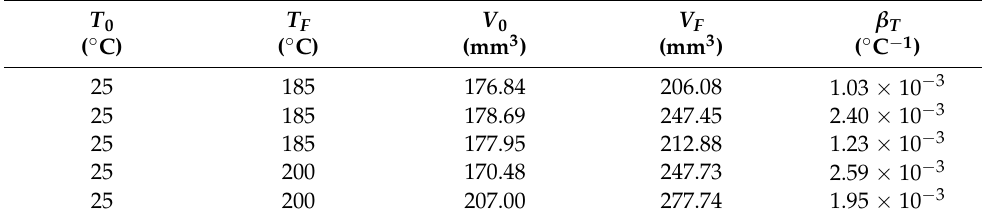
Table 4. Calculated values of volumetric thermal expansion coefficient ( β T ) for PS.